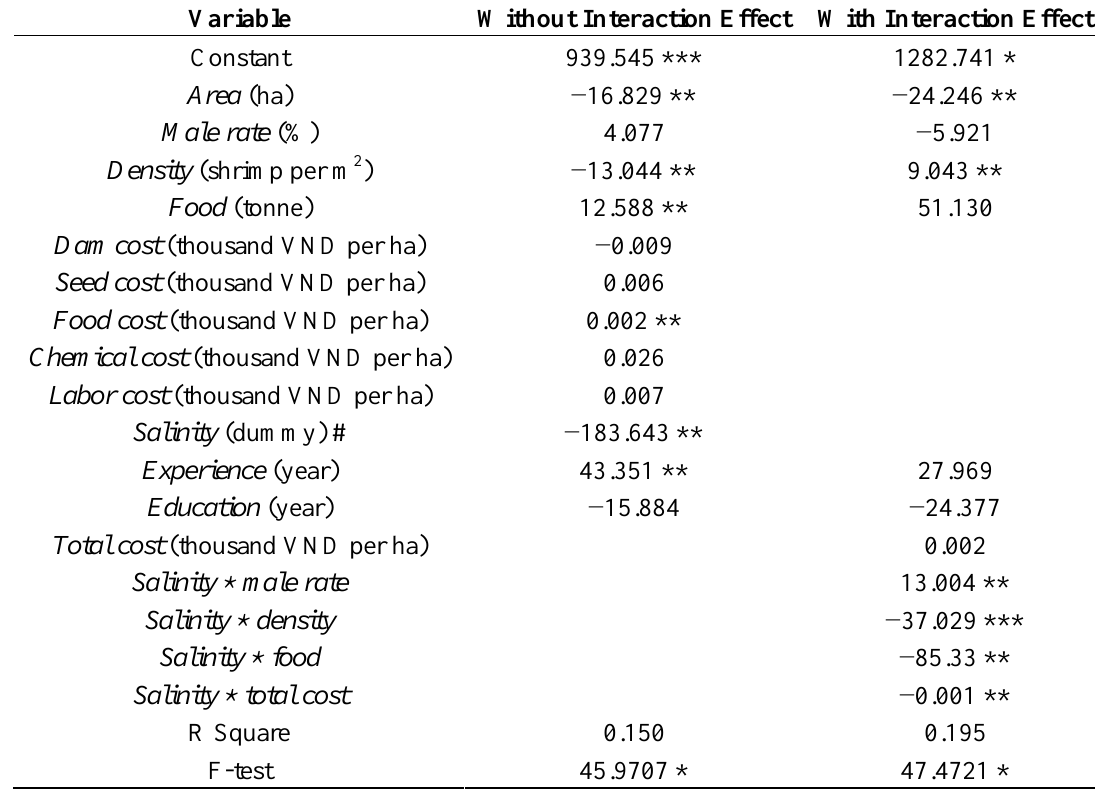
Table A4. OLS estimation of aquaculture production function with salinity impact, dependent variable: yield (kg/ha).